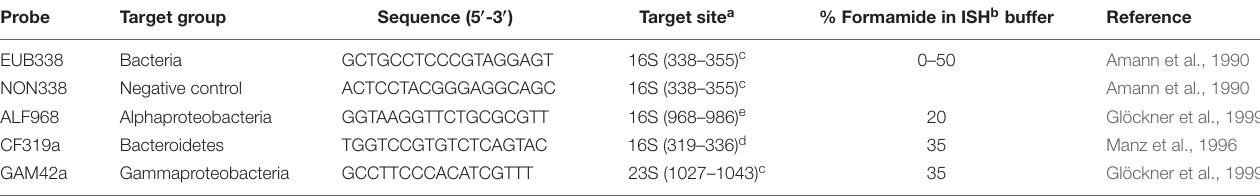
TABLE 1 | Oligonucleotide probes used in this